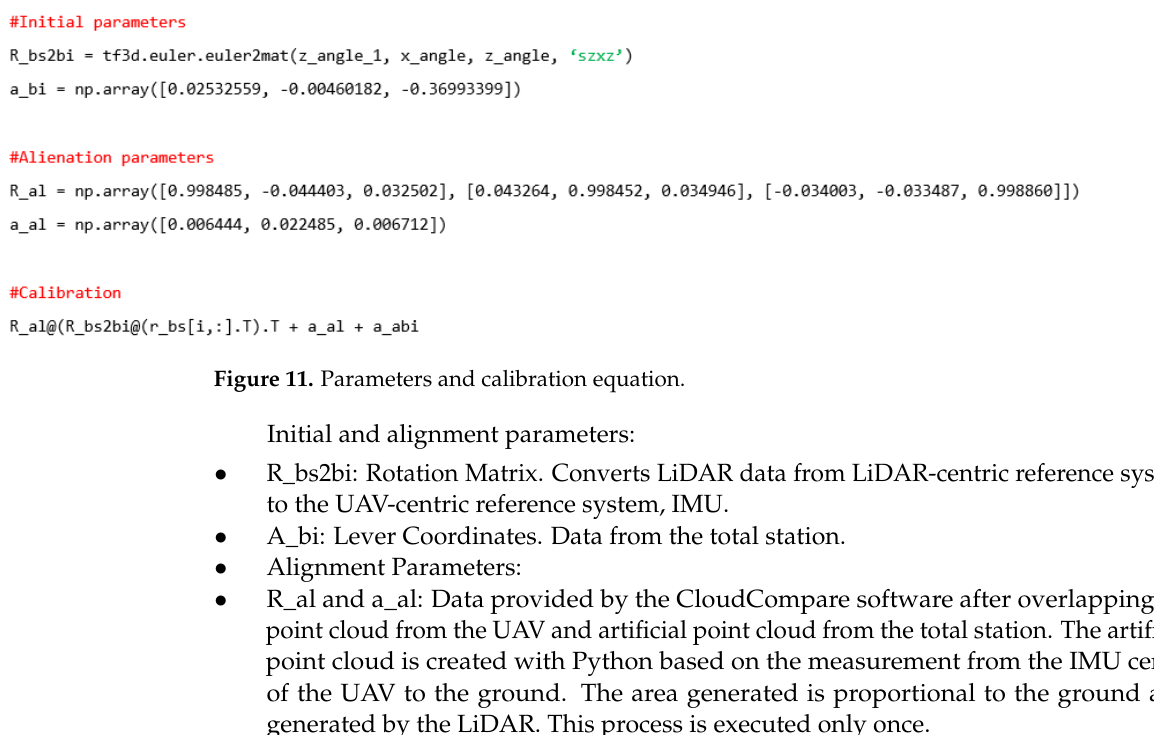
Figure 10. Non- calibrated point cloud RP in the UAV reference system (x’, y’, z’). Figure 11 shows the initial parameters, alignment parameters, and calibration equa- tion used for point cloud calibration. The parameters are detailed below.